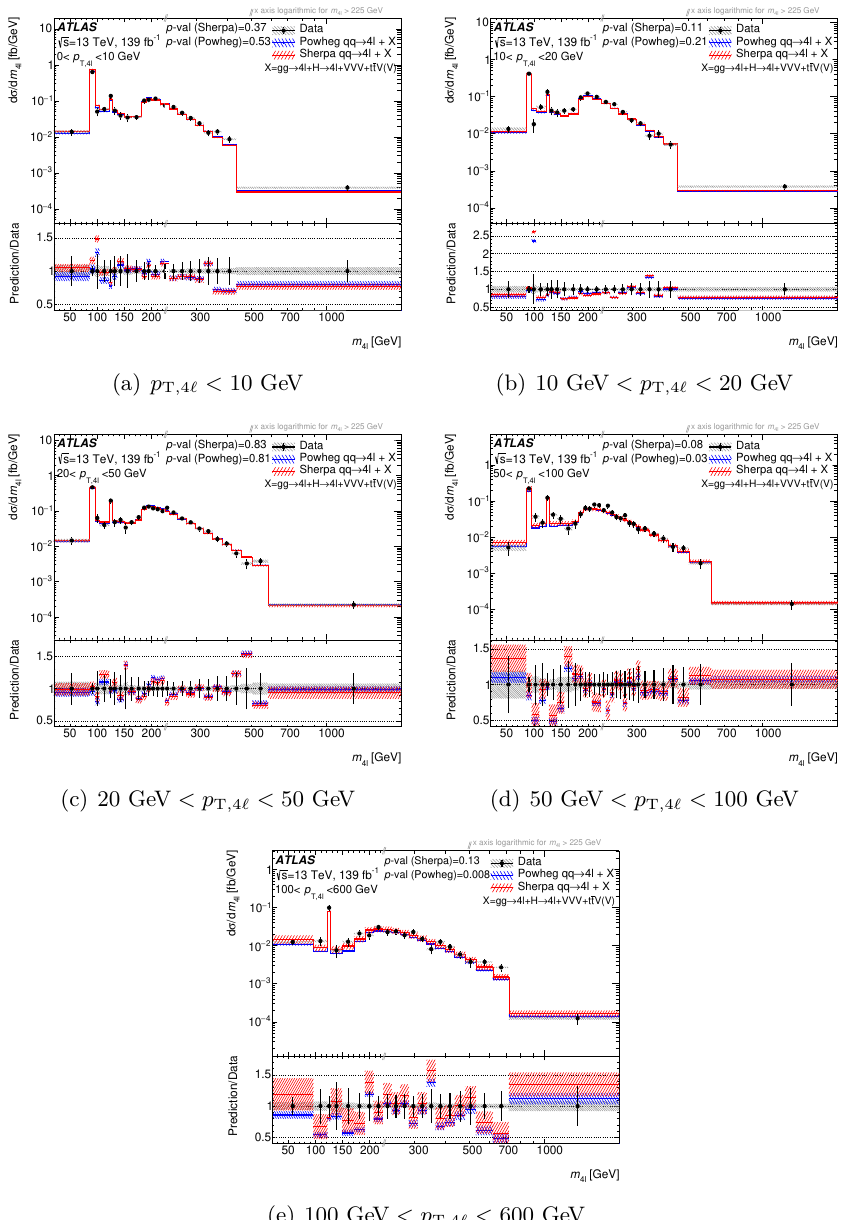
Figure 15 . Differential cross-section as a function of m 4 ‘ in p T , 4 ‘ slices. The measured data (black points) are compared with the SM prediction using either Sherpa (red, with red hashed band for the uncertainty) or Powheg + Pythia8 (blue, with blue hashed band for the uncertainty) to model the q ¯ q → 4 ‘ contribution. The error bars on the data points give the total uncertainty and the grey hashed band gives the systematic uncertainty. The p -value is the probability for the χ 2 , with the number of degrees of freedom equal to the number of bins in the distribution, to have at least the observed value, given the SM prediction. The lower panel shows the ratio of the SM predictions to the data. The x -axis is on a linear scale until m = 234 GeV for the p 10 GeV 4 ‘ T , 4 ‘ < slice and m = 225 GeV for all other slices, when it switches to a logarithmic 4 ‘